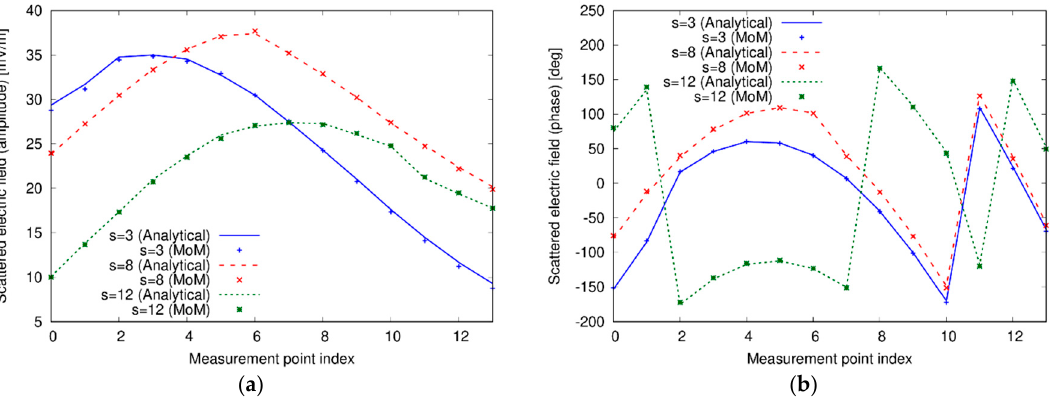
Figure 3. ( a ) Amplitude and ( b ) phase of the scattered fields in some of the considered view computed by the analytical forward solver based on the cylindrical wave approach (CWA) and by the integral equation formulation used in the inverse scattering procedure. Single dielectric cylinder.